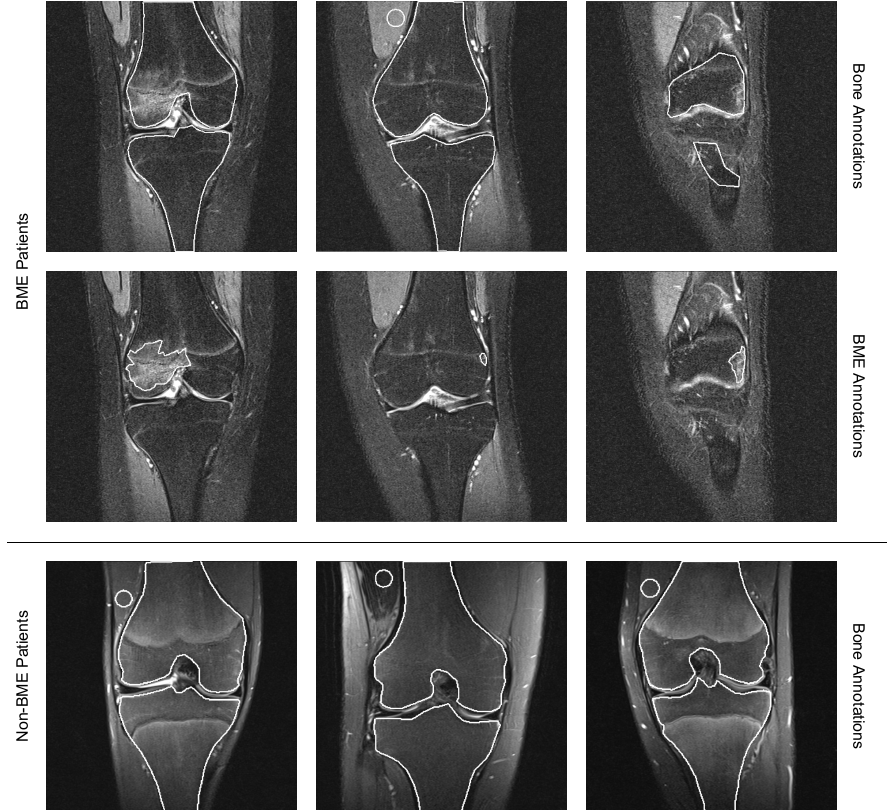
Figure 1. Examples of fluid-sensitive sequences for patients with and without BME. The first and sec- ond rows represent examples of MRI of BME patients with the bone segmentations in the first row and the segmentation of the BME regions in the second row; the third row contains the bone annotations from three different non-BME patients, as well as a rounded annotation in the quadriceps